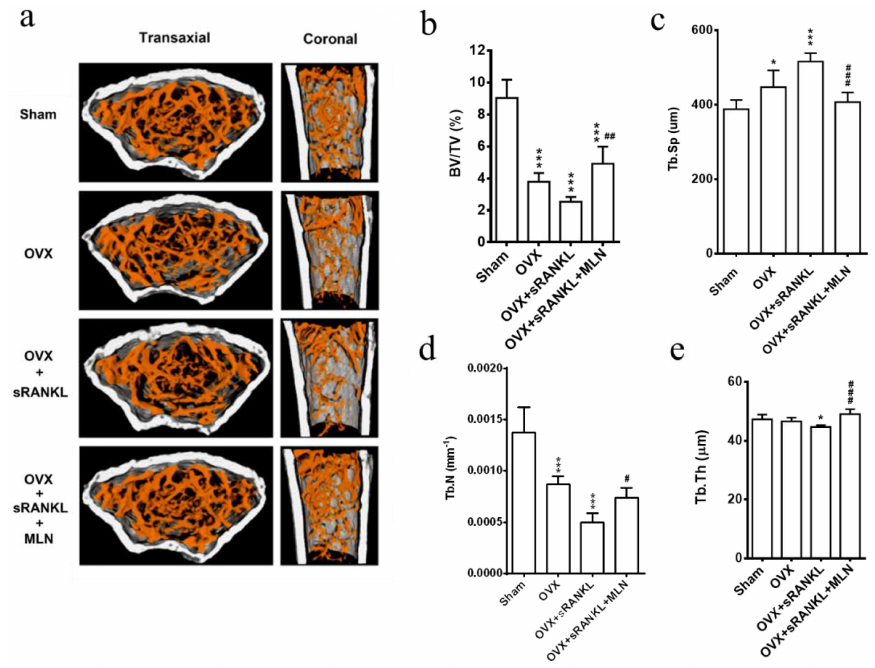
Figure 6. Assessment of MLN4924-treatment in ovariectomy (OVX) and soluble receptor activator of nu- clear factor- κ B ligand (sRANKL)-induced osteoporosis mouse model. ( a ) Micro-computed